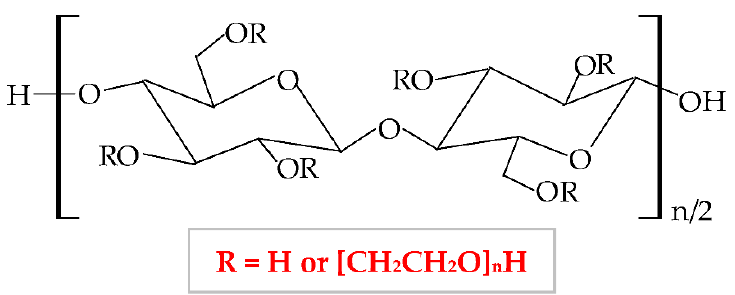
Figure 10. Chemical structure of hydroxyethylcellulose (HEC).